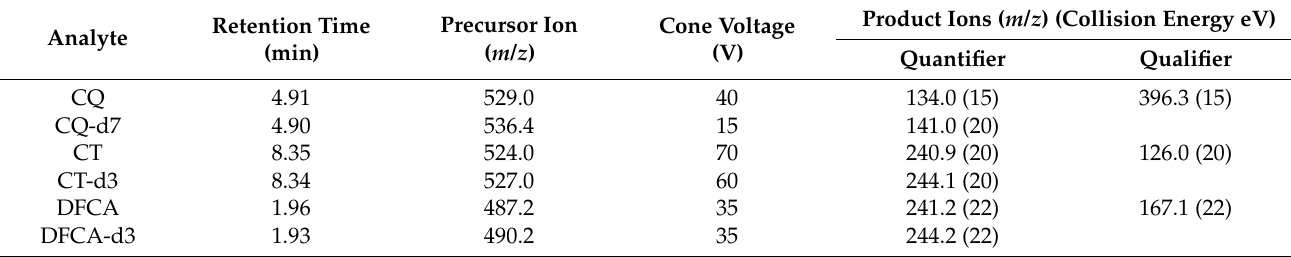
Table 1. Liquid chromatography-tandem mass spectrometric parameters for the analysis of cefquinome (CQ), ceftiofur (CT) and desfuroylceftiofuracetamide (DFCA) and their respective internal standards (CQ-d7, CT-d3 and DFCA-d3) in spiked porcine